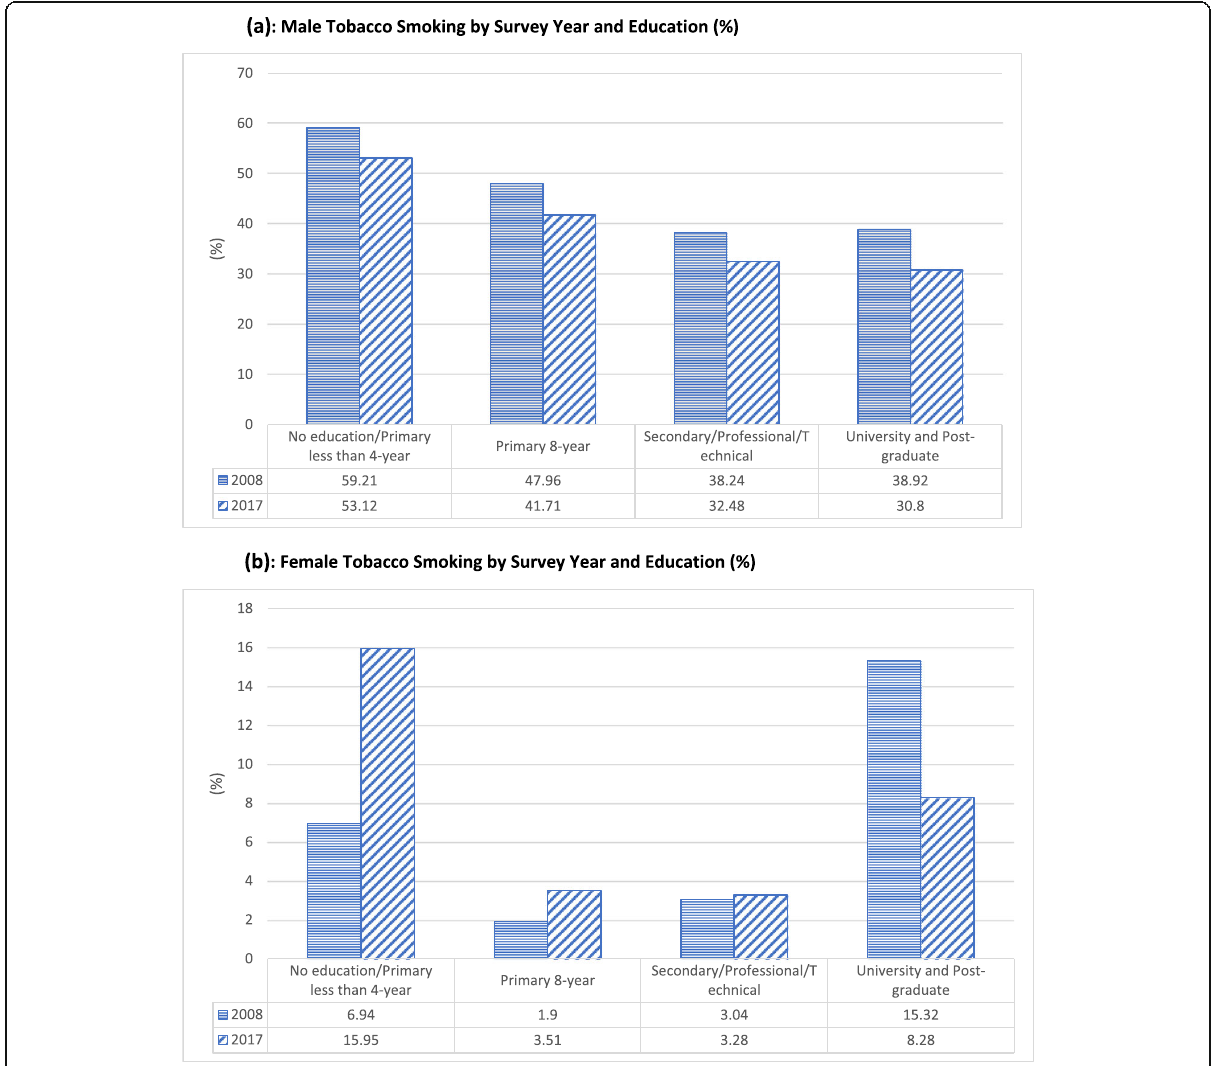
Fig. 4 a Male Tobacco Smoking by Survey year and Education (%). b Female Tobacco Smoking by Survey year and Education